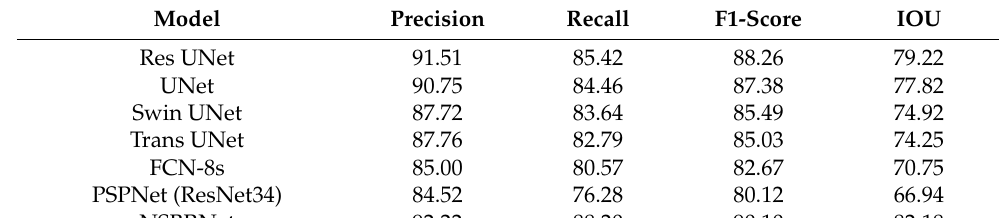
Table 3. Performance of each model in the CZI dataset.